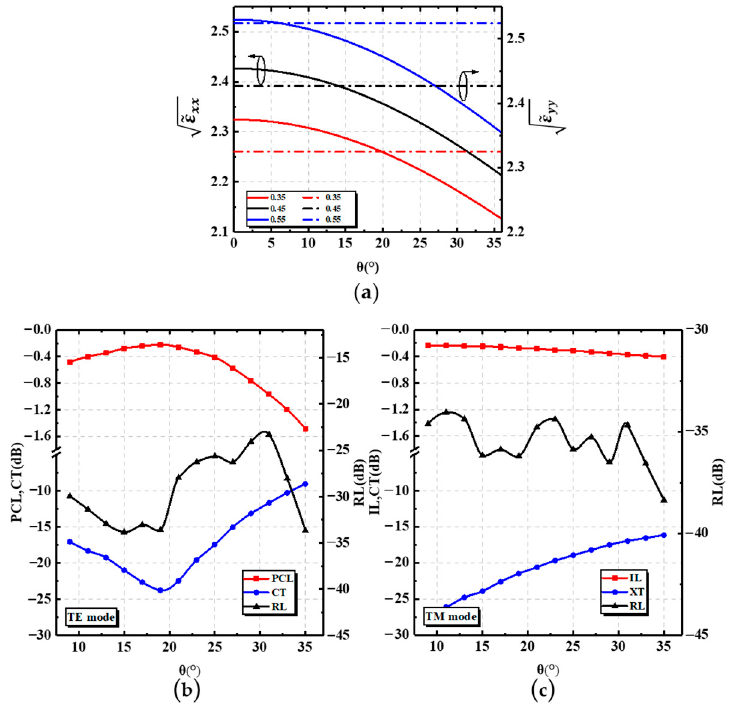
√ (cid:112) Figure 3. ( a ) (cid:101) ε xx and (cid:101) ε yy as functions of θ . Dependence of PCL, CT, and RL on θ for ( b ) the TE Figure 3. ( a ) (cid:3493)𝜀̃ (cid:3051)(cid:3051) and (cid:3493)𝜀̃ (cid:3052)(cid:3052) as functions of 𝜃 . Dependence of PCL, CT, and RL on 𝜃 for ( b ) the mode and for ( c ) the TM TE mode and for ( c ) the TM mode.